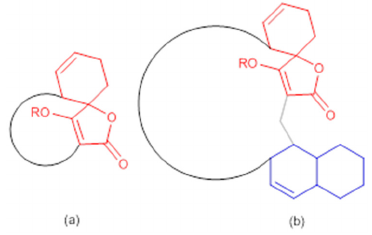
Figure 3. General structures of spirotetronate polyketides ( a ) Class I and ( b ) Class II (modified from [53]). In red: spirotetronate moiety; in blue: decalin moiety.